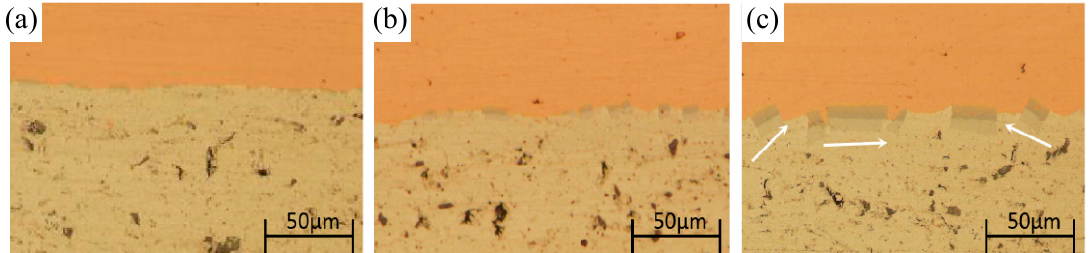
Figure 10. Evolution of intermetallics with further cold rolling. Before cold rolling the composites were annealed at ( a ) 350 °C; ( b ) 400 °C; ( c ) 450 °C.